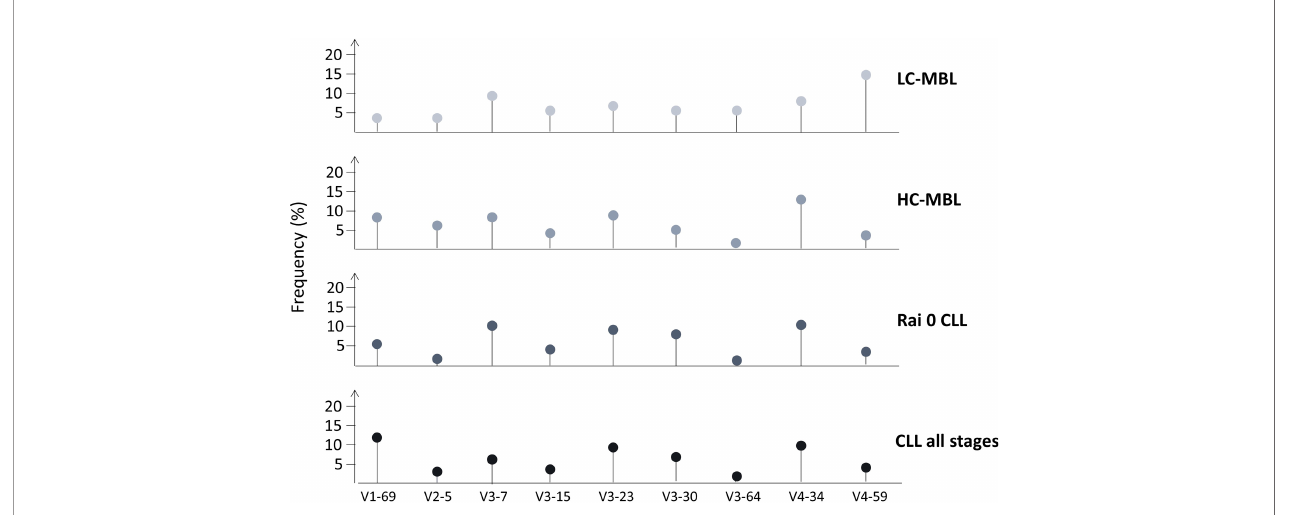
FIGURE 4 | IGHV gene repertoire differences between LC-MBL, HC-MBL, Rai 0 CLL as well as in CLL from all stages. Data was obtained from Vardi et al.